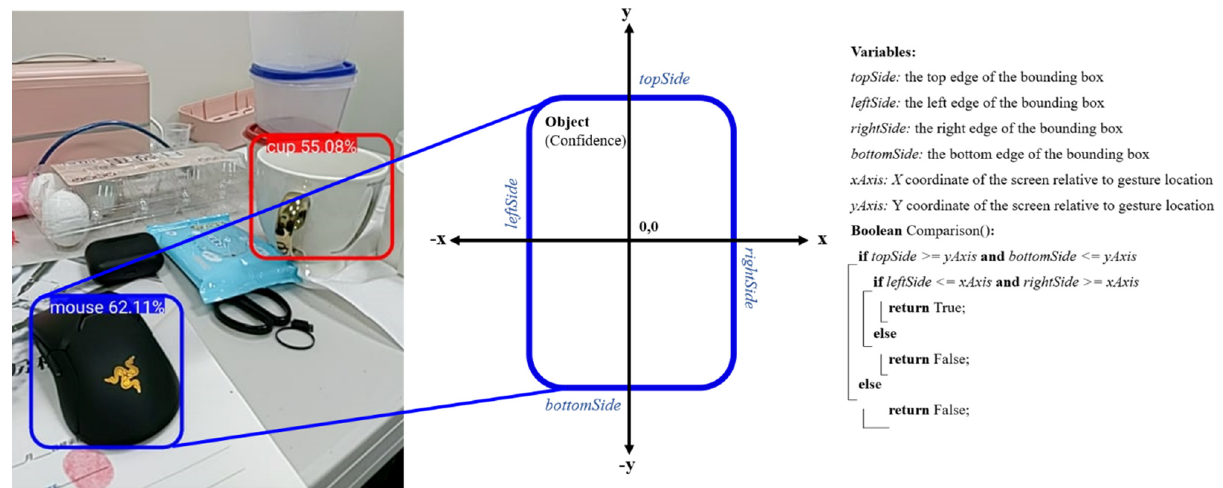
Figure 7. Object detection unique interactable feature that activates whenever gesture input is detected within the bounding box. Table 2. List of different touch gestures and voice commands with its function and feedback.